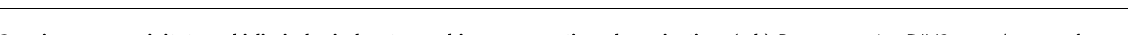
Figure 8 | Gpsm2 co-immunoprecipitates whirlin in brain lysates and increases actin polymerization. ( a , b ) Representative DIV2 growth cones from a control ( a ) and a Gpsm2 cKO ( b ) with the outlined peripheral region where sptPALM data were collected (yellow) and the corresponding individual actin- mEOS2 trajectories (3min recording). Note the overall more-confined behaviour of the actin molecules in the cKO. Scale bars, 5 m m. ( c ) Distribution of the actin-mEOS2 trajectory length shows a median trajectory length of nine frames for both genotypes (blue line). ( d ) Representative mean squared displacement (MSD) over time for each of the three types of actin-mEOS2 behaviours with their corresponding a values. The plain curves represent fits to the function MSD ¼ 4Dt a , where D is a diffusion coefficient and a is a power law exponent. ( e ) Repartition of the a values of actin-mEOS2 molecules in control and Gpsm2 cKO neurons on N-cadherin substrate. Values from 11 (control) and 12 (cKO) growth cones from three separate experiments ( ± s.e.m., n ¼ 1344 trajectories for control and 1121 for mutant). *** P o 0.001, ** P o 0.01, * P o 0.05 with an unpaired Student’s t -test or Mann Whitney test when a normality test failed. NS, not significant. ( f ) Immunoprecipitation of Gpsm2 together with whirlin using anti-Gpsm2 serum. Membranes were immunoblotted with the antibodies indicated on the left. The experiment was replicated twice. ( g ) DIV3 hippocampal neurons electroporated with eGFP– myosin 15, DsRed-whirlin and myc-Gpsm2 show enrichment of all three proteins at the tips of filopodia (arrowheads). Filopodia are outlined with dotted lines. The LUTwas modified (left, Orange hot) to better visualise the accumulation. n ¼ 5 independent experiments. Scale bar, 4 m m. ( h ) Actin assay shows that the combination of Gpsm2 FL and G a i3 expression shift the F/G-actin ratio, whereas the Gpsm2 R318RfsX8 mutation decreases this shift. Dot plot from five biological repeats (black bar represent mean values). ** P o 0.01 with Unpaired Student’s t -test, ** P o 0.01 with one sample t -test. ( i ) Actin assays on cultures of neurons show a shift in the F/G-actin ratio, suggesting a decrease in actin polymerization in the Gpsm2 cKOs. Dot plot from five biological repeats (black bar represent mean values). ** P o 0.01 with one sample t